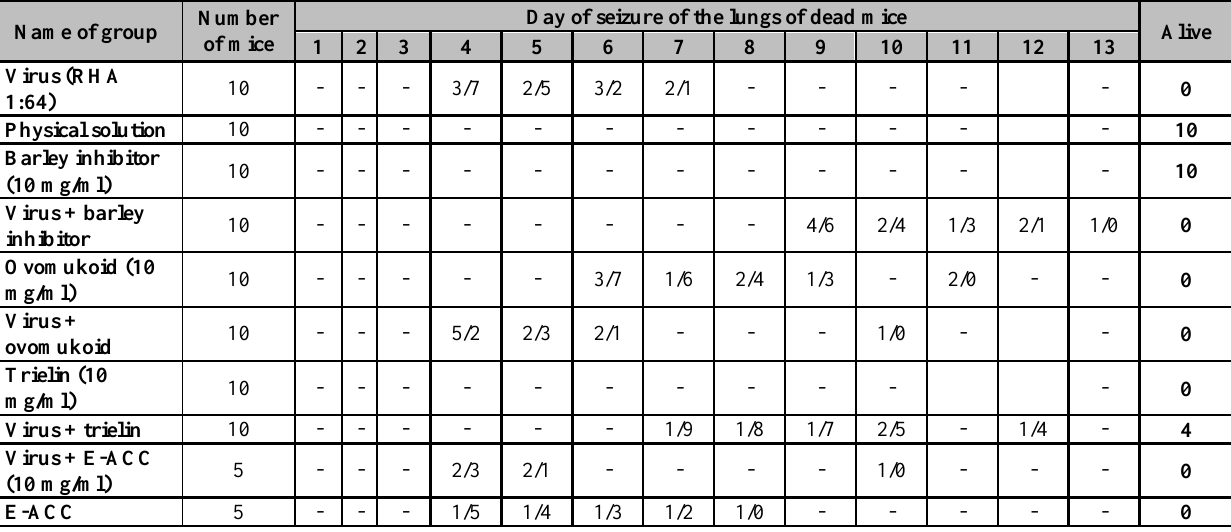
virus A/P/R/8/34